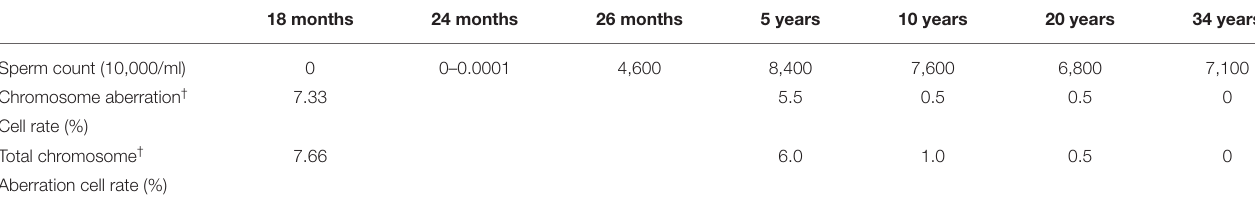
TABLE 1 | Cell rate of semen and chromosome aberration at different times after irradiation.